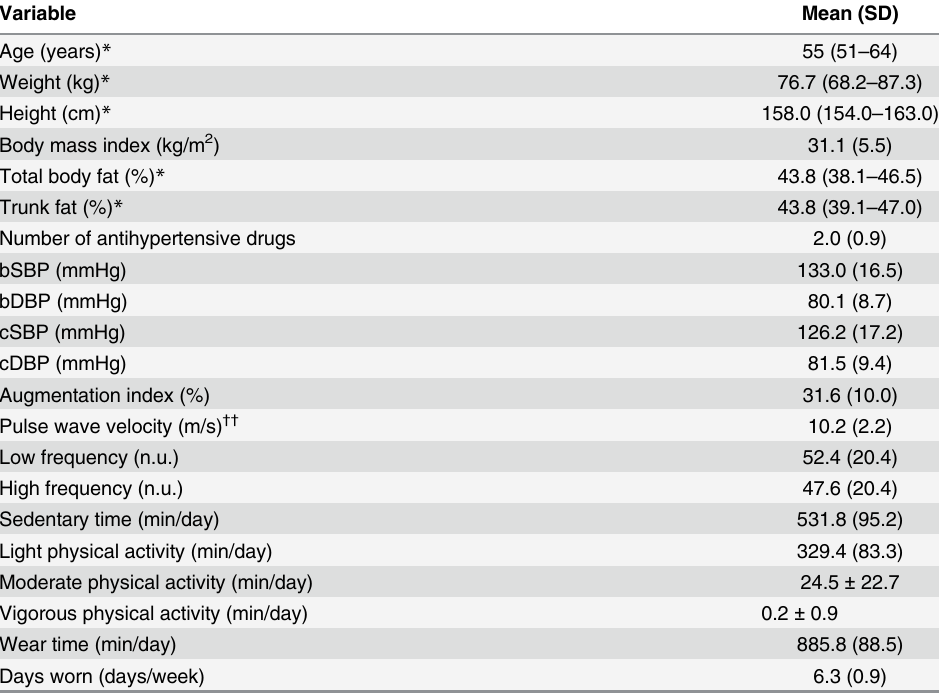
Table 1. General characteristics, physical activity and cardiovascular risk factors information of par- ticipants (n = 87).